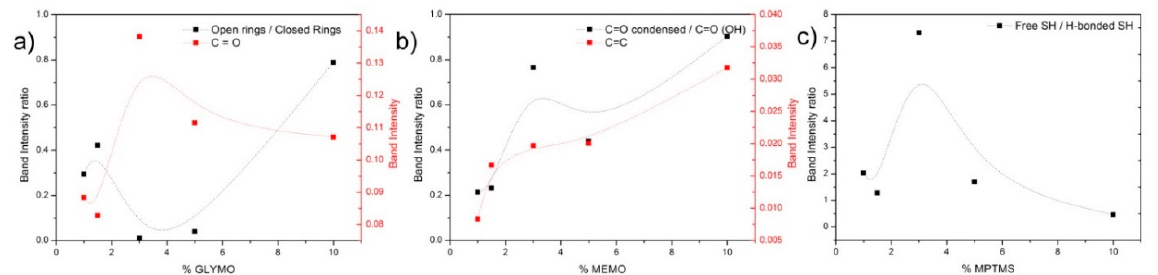
Figure 4. ( a ) Relative intensity ratio of the bands centered at 1270 to 908 cm − 1 (left axis) and relative intensity of the band at about 1250 cm − 1 (right axis); ( b ) relative intensity ratio of the bands centered at 1723 to 1703 cm − 1 (left axis) and relative intensity of the band at about 1635 cm − 1 (right axis); ( c ) relative intensity ratios of the bands centered at 2570 to 2550 cm − 1 . Lines are plotted to guide the eye.